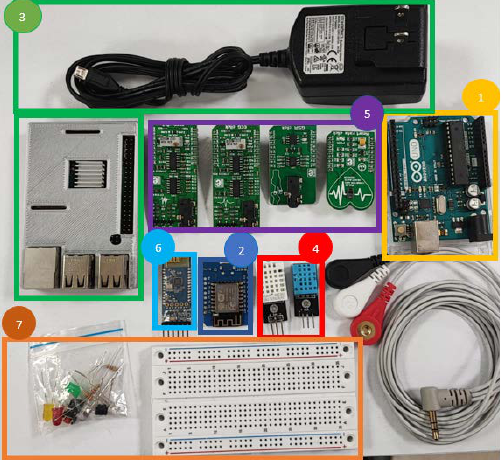
Figure 8. The materials and devices used to implement the all